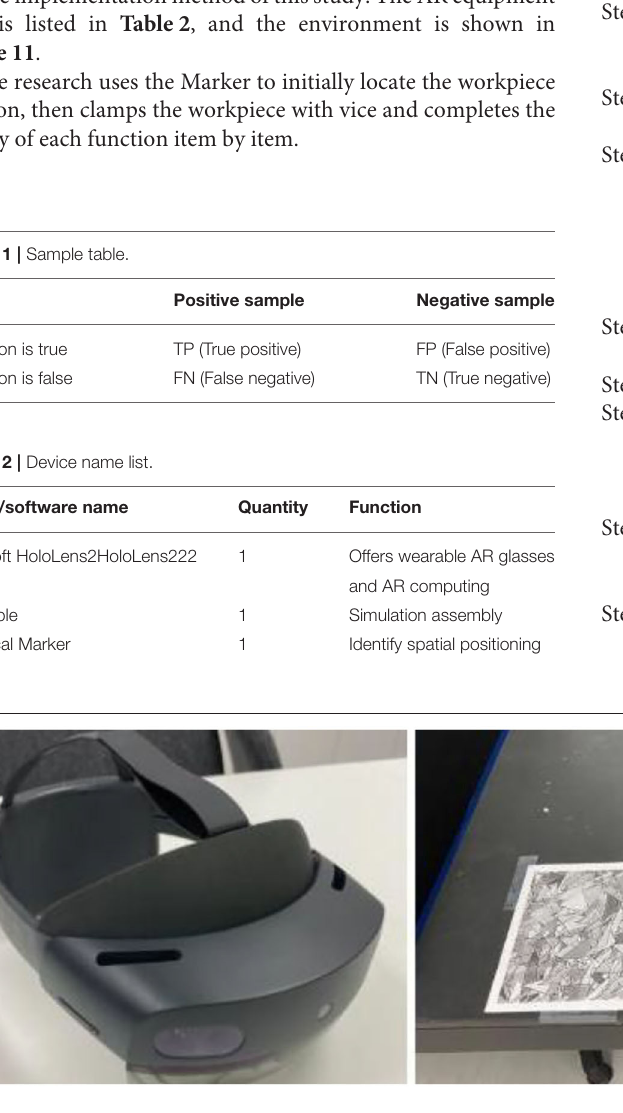
FIGURE 11 | HoloLens2HoloLens222 (Left) and marker and vice (Right) .